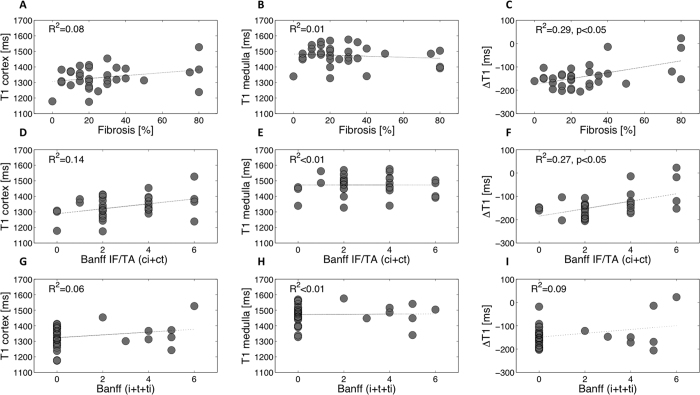
Correlations between histopathological results (fibrosis estimated by
pathological assessment of Masson trichrome (A–C), Banff
IF/TA (ci+ct) (D–F) and Banff (i+t+ti)
(G–I)) and T1 values in the cortex and medulla, and
ΔT1 in 33 KARs. ΔT1 (in ms) was calculated as the
difference between cortical and medullary T1. In all case, no correlation
was found when comparing T1 to histopathological results in the cortex and
medulla alone. A moderate correlation was found between ΔT1 and
the percentage of cortical IF estimated by pathological assessment of Masson
trichrome (C) and also, between ΔT1 and fibrosis
estimated by Banff IF/TA (ci+ct) with respectively
(R2 = 0.29 and
R2 = 0.27,
p < 0.05) (F).